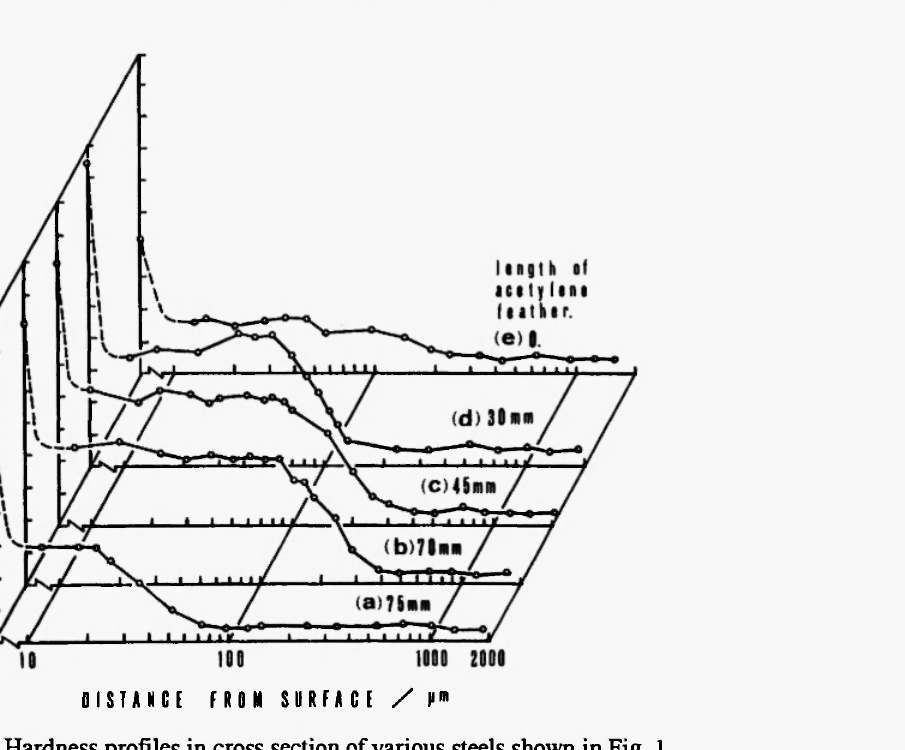
Fig. 3: Hardness profiles in cross section of various steels shown in Fig. 1. ray diffraction pattern (b) of low carbon steels treated for 0.42 ks with a feather length of 40 mm are shown in Fig. 4. The exposure time with feather of Fig. 4 is longer than that of Fig. lc. α-Fe is confirmed as a main component and Fe3C is also clearly detected. The surface hardness appears to be Hv(10g)679 higher than that of the Fig. 3c case. The thickness of the carburized layer was estimated 270 μιη from the hardness measurement. Namely, the carbon concentration of the substrate surface increases with the increase of treatment time, and this induces the formation of FejC. Wear resistance was examined on the portions of the center denoted by (A) and 8 mm away from the center (B) of the substrate shown in Fig. 4. The specific wear rate for (A) and (B) were 2.1 χ 10~ 7 and 4.9 χ 10"